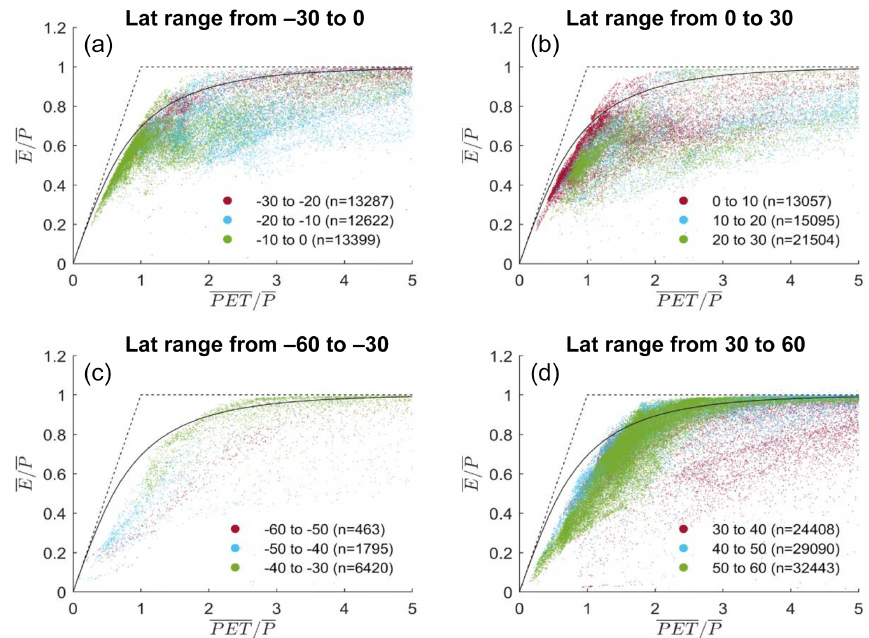
Figure 2. The traditional Budyko framework for long-term water balance along with the asymptotes and the Budyko curve (ET /P = [ ( 1 − exp ( − PET /P)) · PET /P · tanh ( PET /P) − 1 ] 0 . 5 ). The ratio of mean annual potential evapotranspiration (PET, demand) to mean annual precipitation ( P , supply) explains the ratio of mean annual evapotranspiration (ET, actual) and P , and the data points are from GLDAS-2 estimates (Rodell et al., 2004) at the pixel level (0.25 ◦ ) for the period 1948–2010 over the Northern Hemisphere ( b, d , 0–30 and 30–60 ◦ latitudes) and Southern Hemisphere ( a, c , 0–30 and − 30 to − 60 ◦ latitudes).